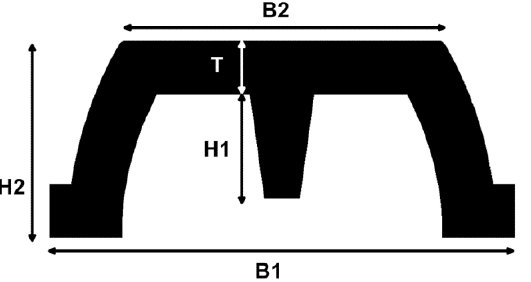
Figure 6. Cross section of the PSP2 silicone cover; the geometrical parameters are: cover thickness T, height of the curtain H1, pyramidal frustum height H2, square base size B1, square top-face size